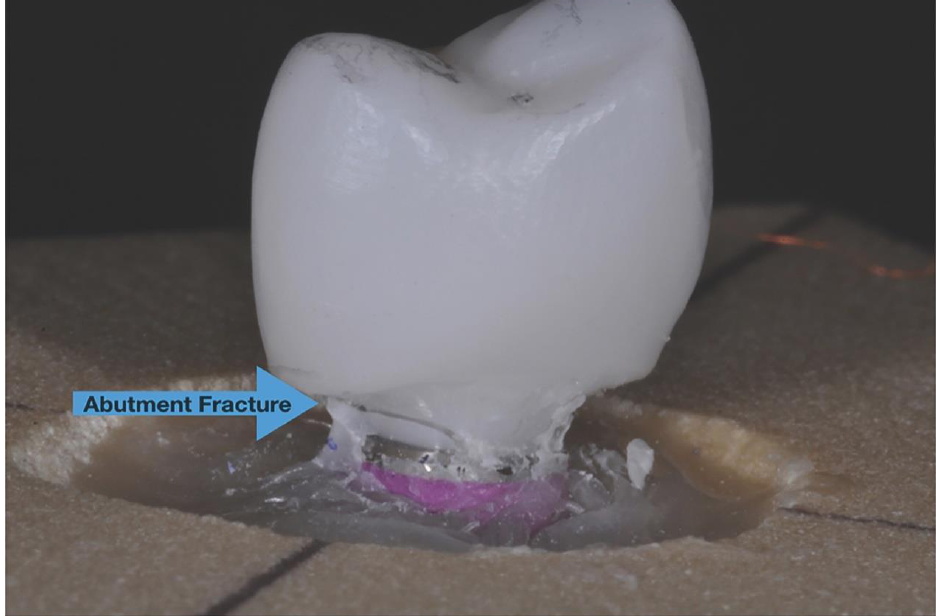
Figure 7. The fracture of zirconia abutment near the interface of zirconia abutment and implant analog which was recorded for all specimens in both groups. analog which was recorded for all specimens in both